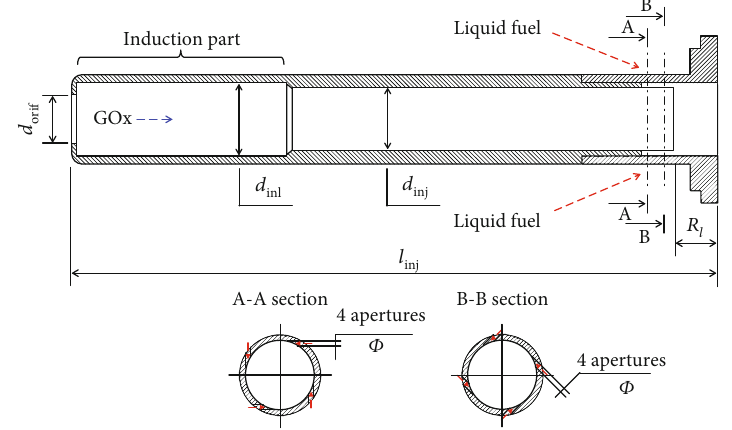
Figure 1: Diagrams of geometry of the model chamber and a single